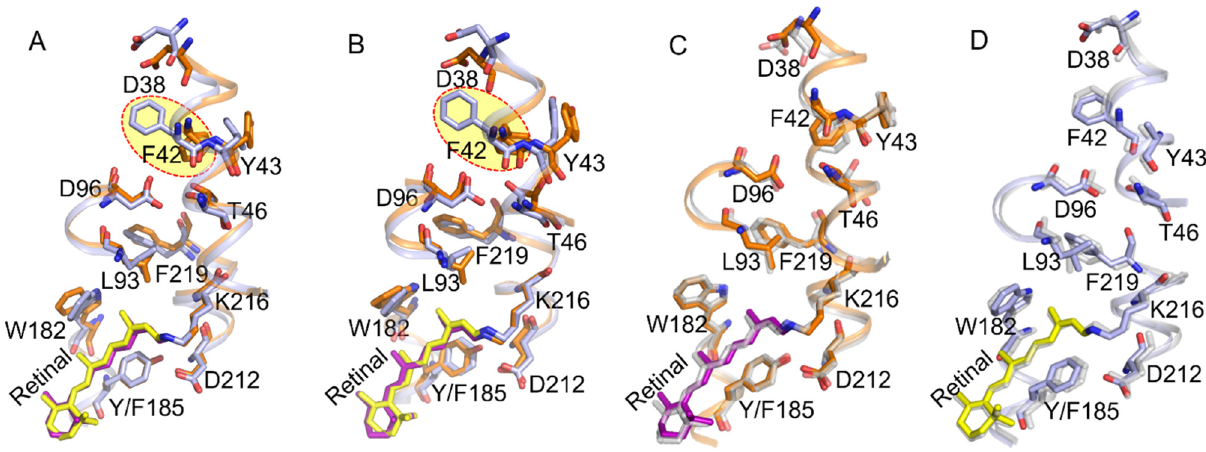
Figure 8. Comparison of the conformation of the cytoplasmic half channel of the M 2 ’ state from the repeated simulations. ( A , B ) WT-M 2 ’ (orange and purple) vs. Y185F-M 2 ’ (light blue and yellow) from the second-and the third-time simulations, respectively. Color codings are the same as used in Figure 2E. ( C , D ) Superimposed presentations of the second-and the third-time simulations of the cytoplasmic half channel of WT-M 2 ’ and Y185F-M 2 ’, respectively. The grey color indicates the second-time simulation.